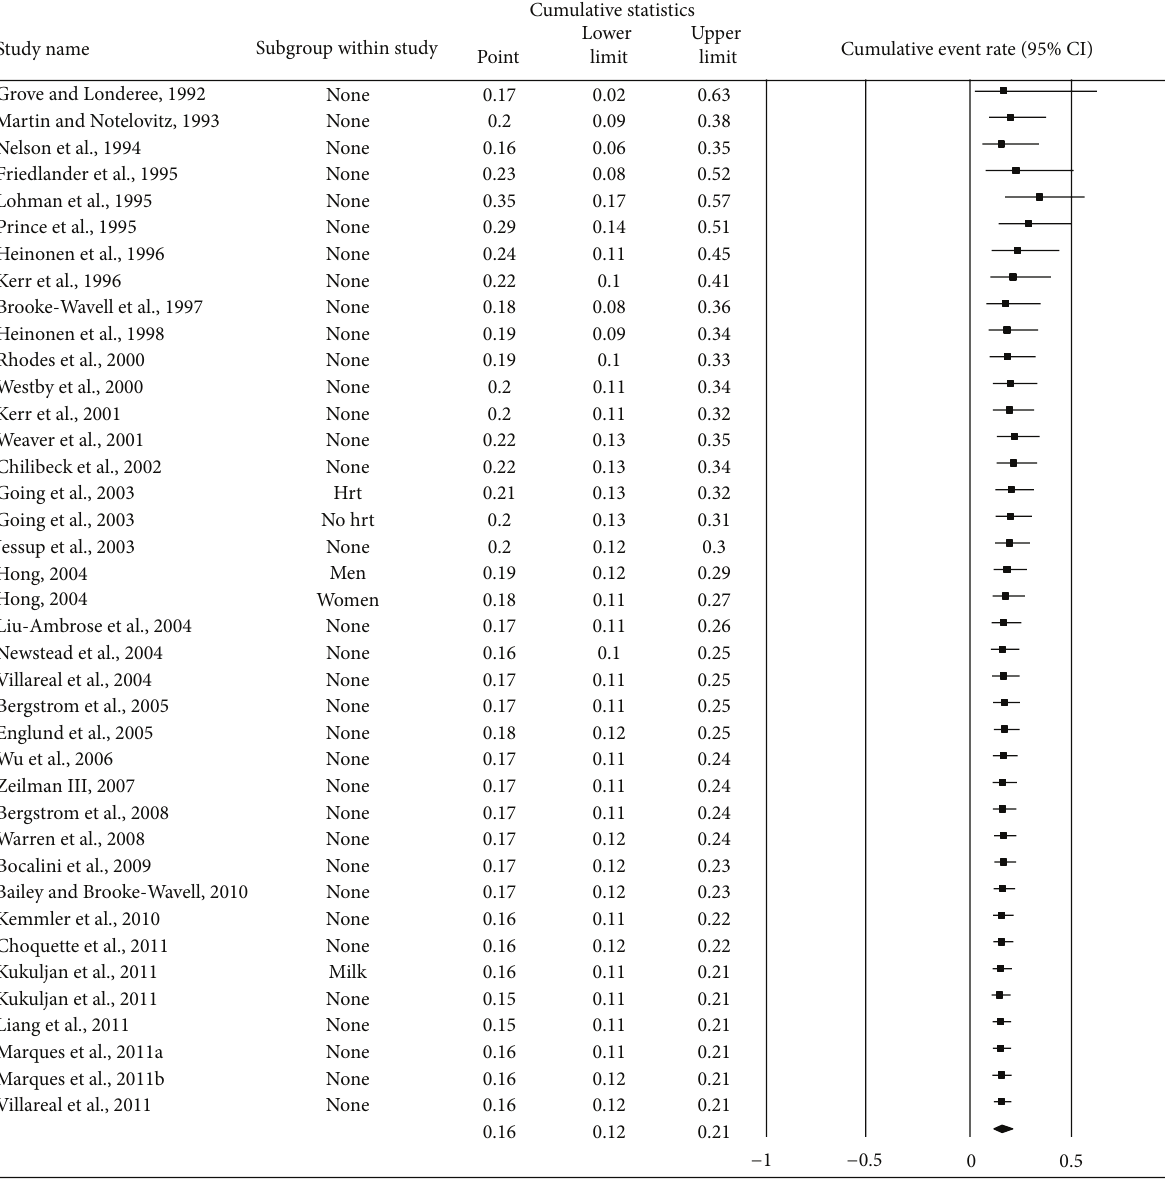
Figure 8: Cumulative meta-analysis for control dropouts. Cumulative meta-analysis, ordered by year, for control group dropouts. The black squares represent the event rate for each group from each study along with their 95% confidence intervals. The results of each corresponding group are pooled with all studies preceding it. The middle of the black diamond represents the overall mean event rate while the left and right extremes of the diamond represent the corresponding 95% confidence